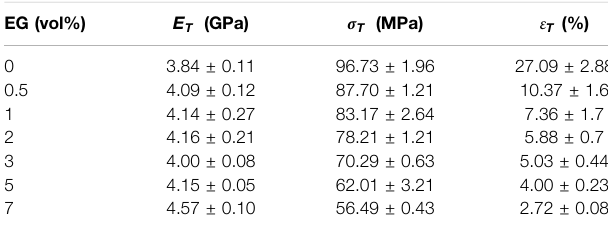
TABLE2| Tensilepropertiesofthecomposites: E T (cid:2) Young ’ smodulus, σ T (cid:2) tensile strength, and ε T (cid:2) elongation at